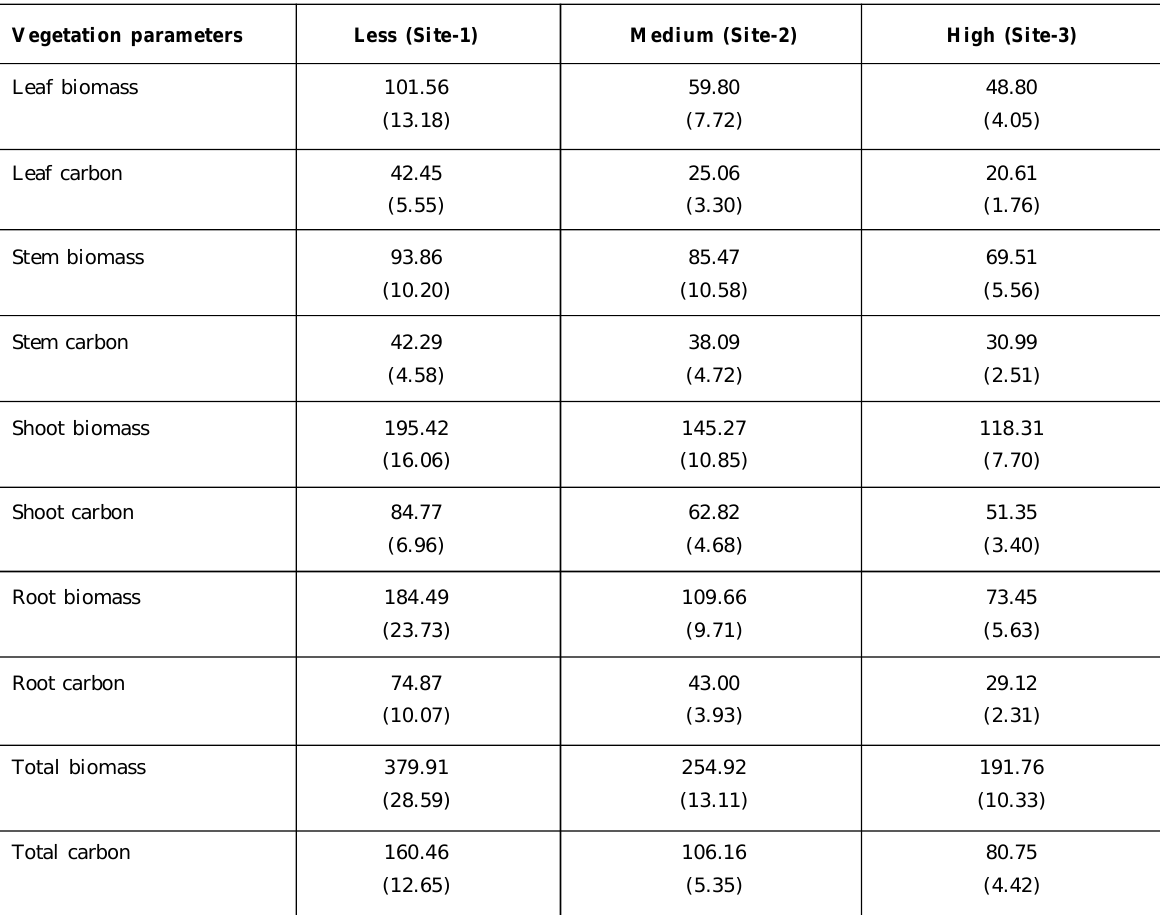
Table 3: Mean value of herbaceous biomass (g m -2 ) and carbon content (g m -2 ) of herbaceous species at three locations of tropical grassland differing in disturbance intensity. Values in parentheses are ± 1 SE .